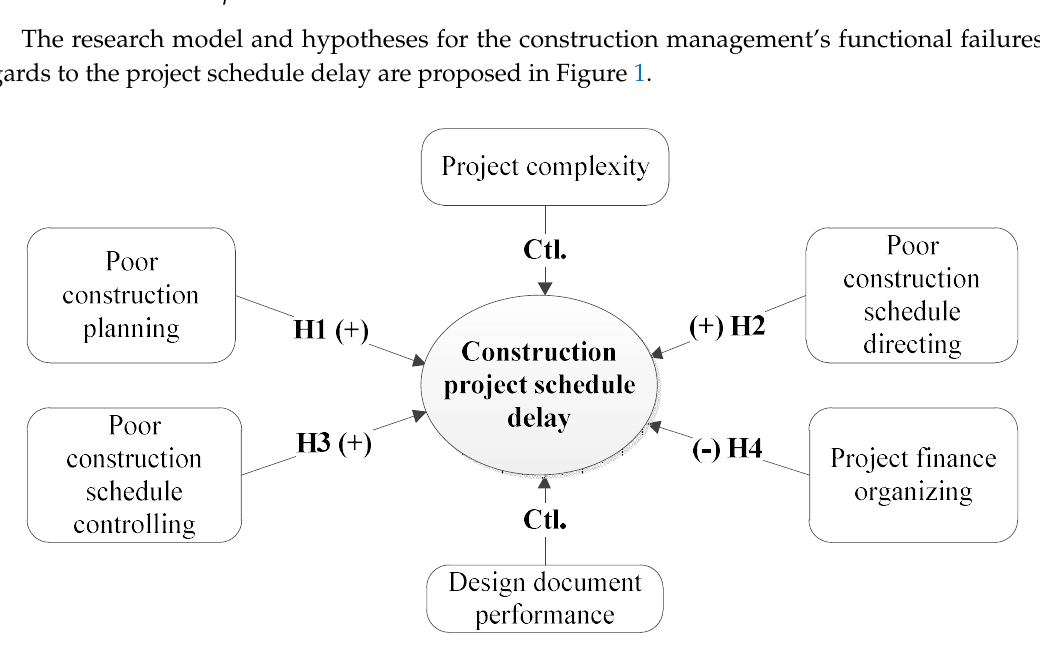
Figure 1. Research model for failures to project schedule delay.